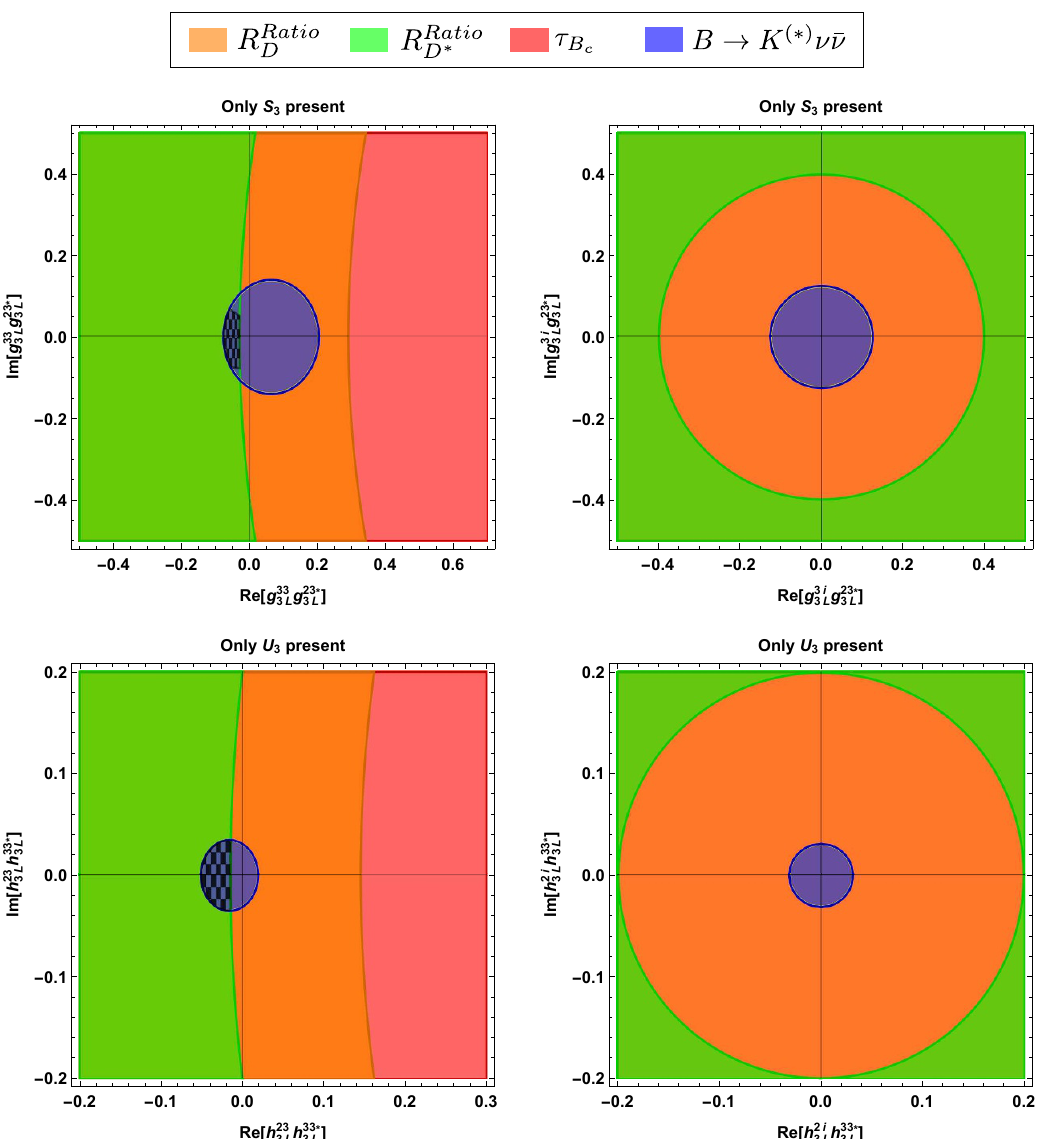
Figure 9 . Constraints on the S 3 and U 3 leptoquark models when considering one coupling at a time. Here, i = 1 , 2 denotes the electron and muon neutrinos. We require that the couplings reproduce the measurements of R Ratio τ − ¯ ν τ ) 30%, and are consistent with the upper bounds on ≤ allowed regions of the parameter space when combining all constraints are highlighted with a black